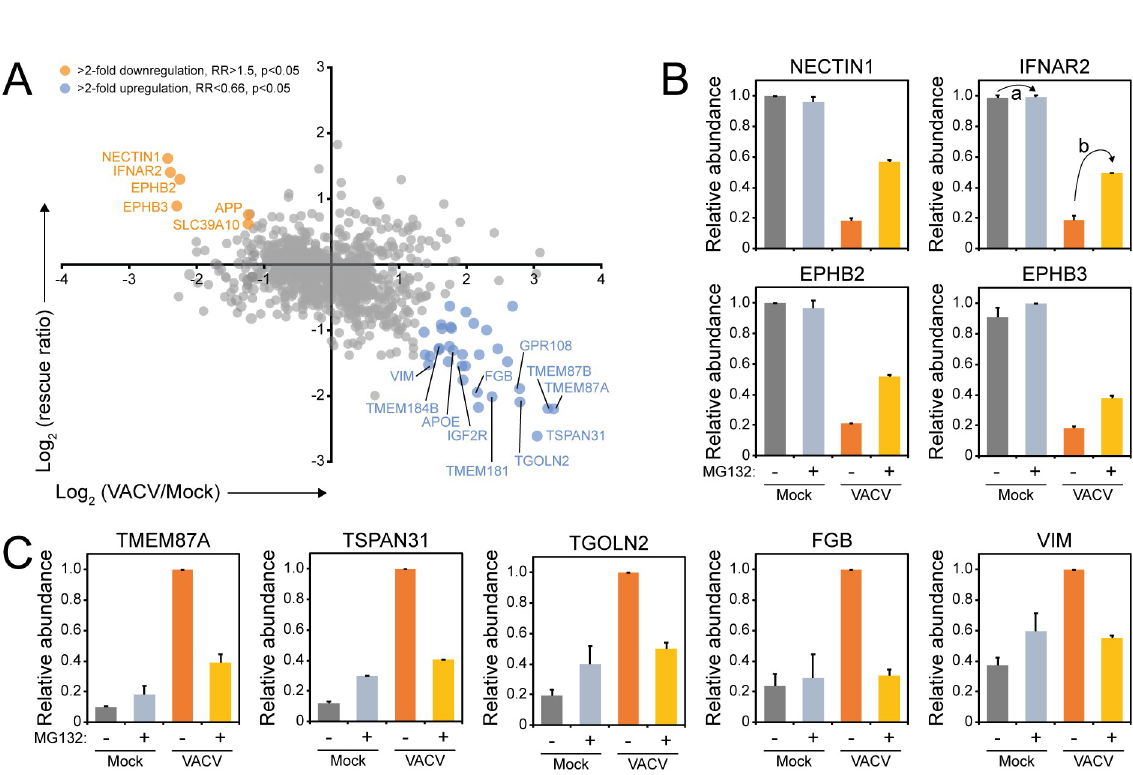
Fig 7. Systematic analysis of proteasome-dependent changes in surface protein expression during VACV infection. ( A ) Identification of human PM proteins downregulated from the cell surface at 18 hpi (compared to 18 h mock) in both replicates and rescued by addition of MG132 ( > 2 FC, rescue ratio (RR) > 1.5, p < 0.05), or upregulated at the cell surface at 18 hpi (compared to 18 h mock) and diminished by the addition of MG132 ( > 2-FC, RR < 0.66, p < 0.05) (S4 Table). Here, we define the RR = b / a, where a = protein abundance during VACV infection +MG132 / abundance during infection -MG132. This value was limited to 1 to avoid artificial ratio inflation. b = protein abundance during mock-treatment +MG132 / abundance during mock -MG132 (see panel B, IFNAR2). P-values were estimated using significance A with Benjamini-Hochberg correction for multiple hypothesis testing [117]. ( B ) Relative abundance of selected human proteins downregulated at the PM at 18 hpi and rescued by addition of MG132. ( C ) Relative abundance of selected human PM proteins for which upregulation was prevented by the addition of MG132 at 18hpi. Data are represented as mean ± SD (n = 2) S1 Table.